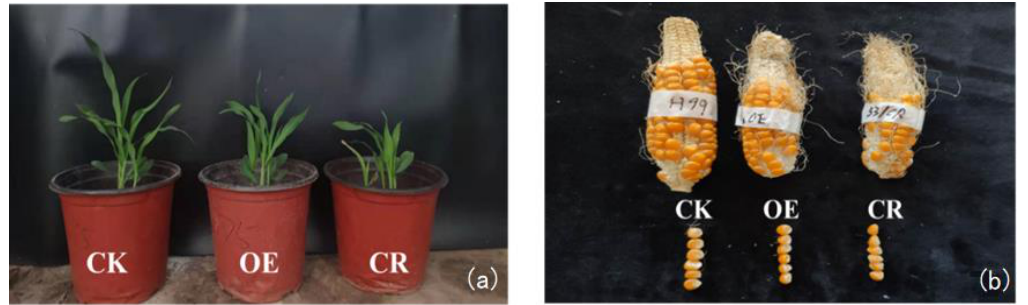
Figure 6. Agronomic traits of transgenic plants. ( a ) comparison of maize traits at the seedling stage and ( b ) Comparison of the ears and seeds of the corn. CK: control plants; OE: transgenic plants overexpressing the ZmBON3 gene; CR: ZmBON3 -gene-edited plants. Table 1. Character survey of T 2 transgenic maize.